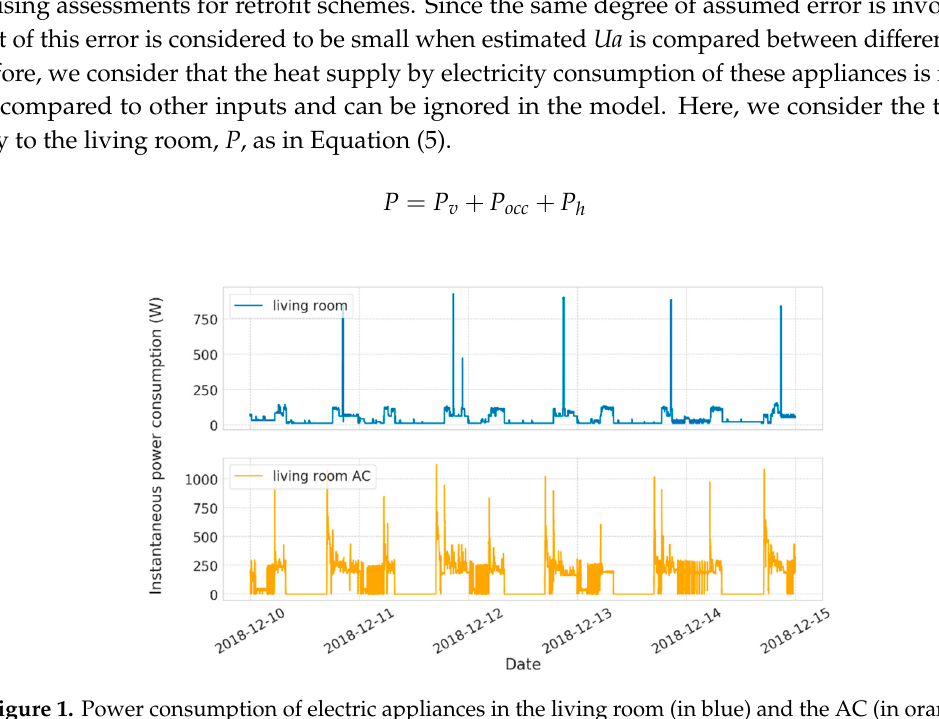
Figure 1. Power consumption of electric appliances in the living room (in blue) and the AC (in orange).